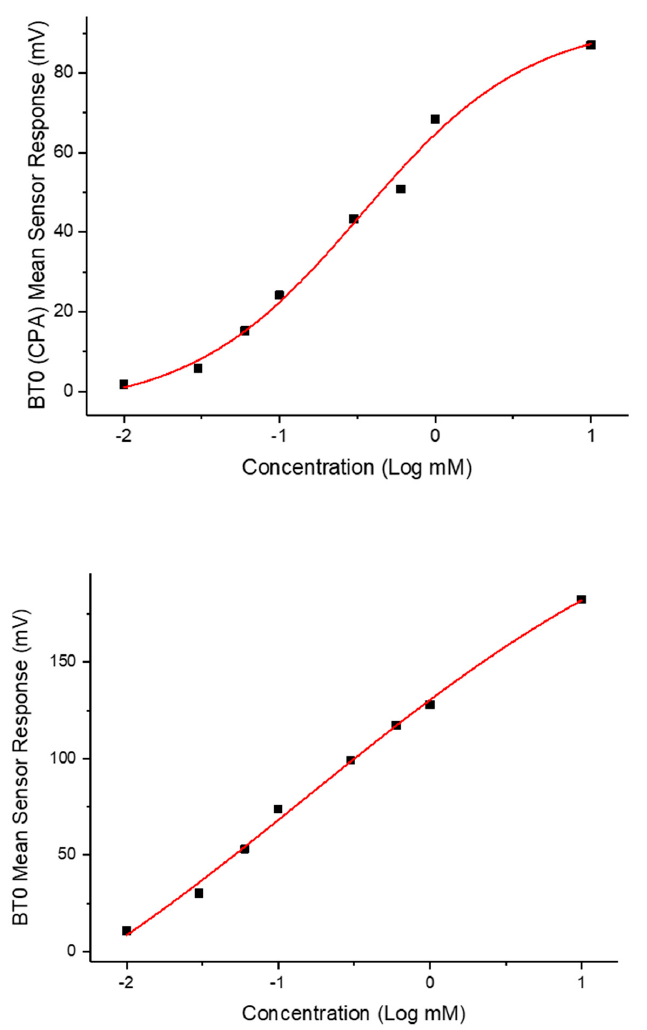
Figure 12. Non-linear Boltzmann fitting of the initial taste (BT0 sensor) and aftertaste (BT0 CPA sensor) of chlorpheniramine maleate.